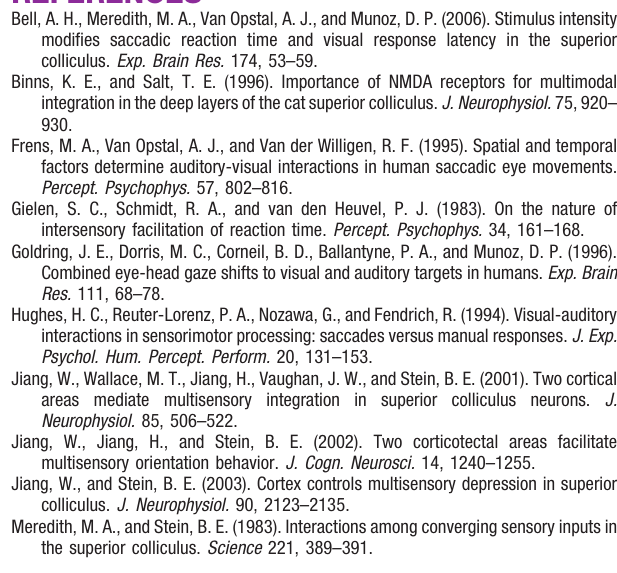
( Figure 6 ). In the first quarter of the multisensory response, unisensory responses were minimal and multisensory event estimates exceed their sum 87% of the time (random ¼ 50%). In the second quarter of the multisensory response, unisensory responses have increased but